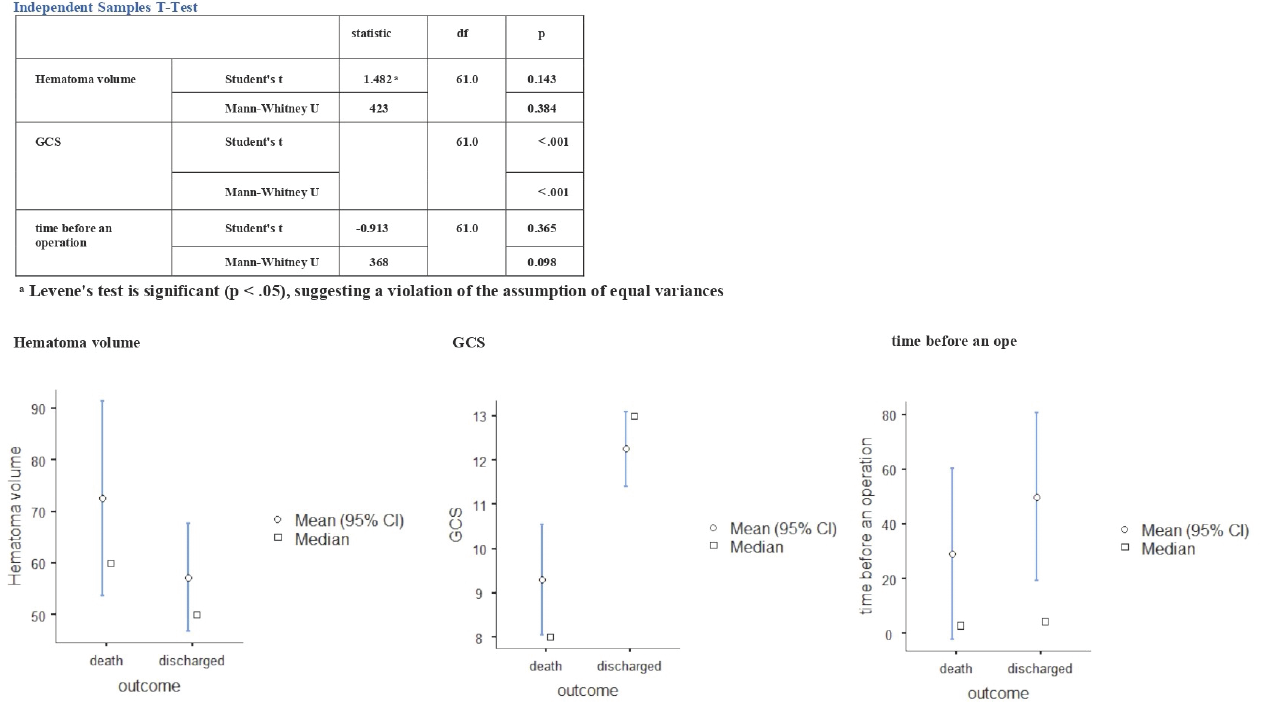
Figure 1 - Correlation between hematoma volume, CGS, time before operation and an